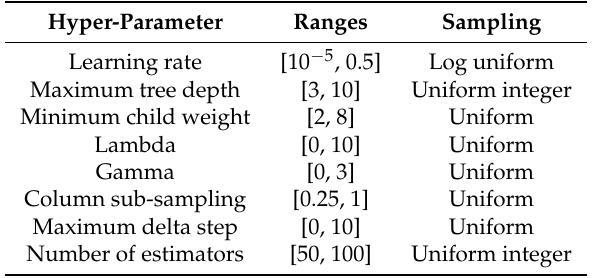
Table 1. Examined values of hyper-parameters.